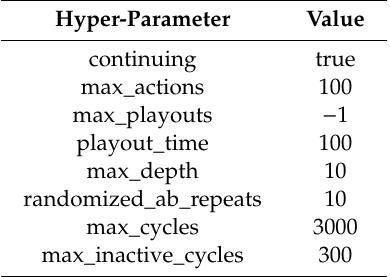
Table 4. Hyper-parameters used in the